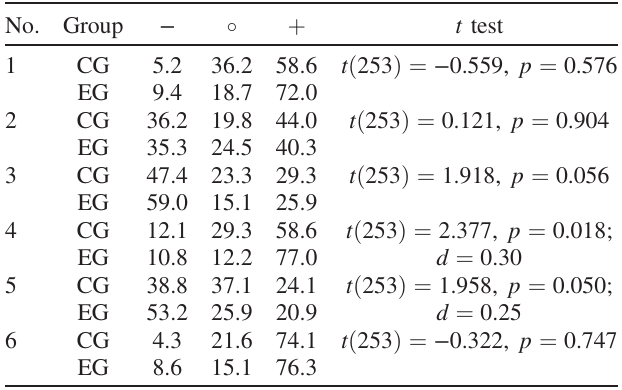
TABLE V. Proportion of students ’ agreements ( þ , rating: rather agree, agree), disagreements ( − , rating: rather disagree, disagree), and undecided votes ( ∘ , rating: undecided) in the items of the scale on conceptions about quantum objects ’ properties and behavior (cf. Table II) in % . Deviations from 100% in the row totals are due to rounding. Mean ratings with standard deviations for items in EG and CG are reported in the continuous text. Test statistics of t tests for independent samples are used to examine differences in means between control and experimental groups for each item.